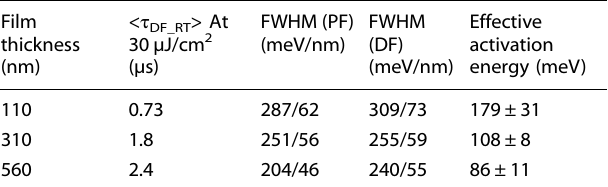
Fig. 3 Time resolved photoluminescence at room temperature. a Time-resolved emission decay of F8BT solution in p -xylene. The inset shows time-resolved PF in F8BT solution. The dotted line is a guide to the eye to show the nature of power-law decay. The solid red line is bi- exponential fi t to experimental data for DF1 and DF2. b Time-integrated DF vs. PF intensity derived for F8BT solution at DF1 (at time delay ~200 ns) and DF2 (at time delay~10 μ s) regions, respectively, the solid line is linear fi t to data for different fl uence range. c Time-resolved emission decay in F8BT neat solid fi lm containing low (30 μ J/cm 2 , solid green square) and high (570 μ J/cm 2 , solid blue circle) laser fl uence. At low fl uence, DF decays exponentially (red solid line) whereas at high fl uence it has power law decay (red solid line). d The time-integrated PF and DF intensity vs. laser fl uence plots for F8BT solid fi lm, linearly fi tted with dual slopes Table 1. Room temperature average triplet lifetimes, broadening of PF, DF emission spectra and effective triplet activation energy parameters of F8BT as a function of fi lm